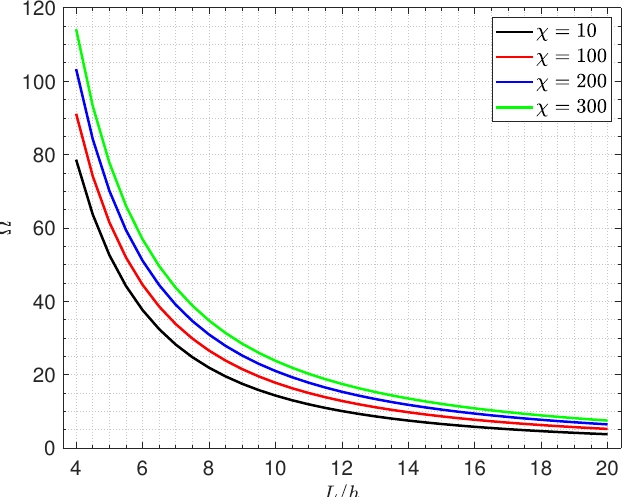
Figure 8. Frequency of the nanocomposite piezoelectromagnetic plate versus the side-to-thickness ratio L / h and the piezoelectromagnetic multiple χ for different values of the external applied magnetic potential P 0 (Type A).